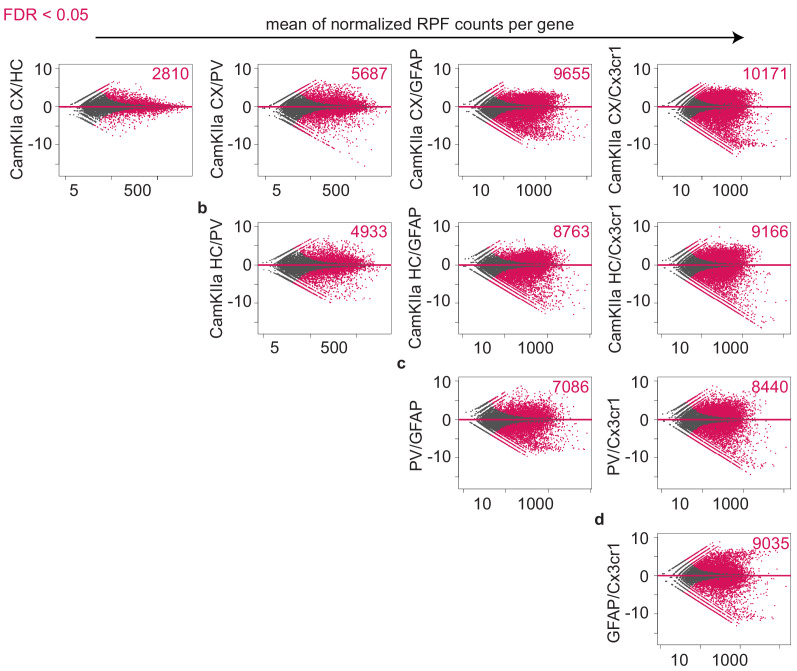
Identification of differentially translated transcripts in different cell types.MA plots showing the log2FC in translation between indicated cell types over the mean of normalized RPFs per gene. Genes that are differentially translated (FDR < 0.05) are colored in pink and the corresponding numbers are indicated.